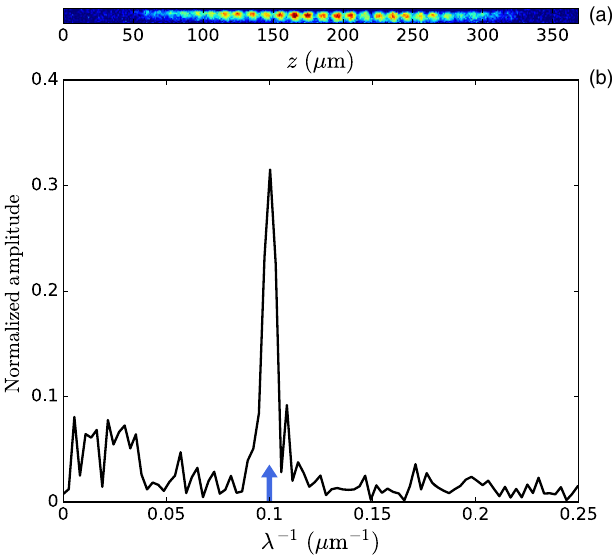
FIG. 1. (a) Column-density image; (b) FFT of the line density. ¯ B ¼ 572 The modulation parameters are ω ¼ ð 2 π Þ 950 Hz, . 5 G, Δ B ¼ 5 G, corresponding to a mean scattering length ¯ a ¼ 4 . 2 a 0 , and a modulation amplitude Δ a ¼ 0 . 9 a 0 , where a 0 is the Bohr ¼ 5 ms and t ¼ 20 ms. The blue arrow radius. In addition, t m h for these parameters. The dc indicates the calculated λ − 1 F component is subtracted, and the FFT amplitude is normalized by this dc